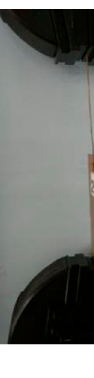
Figure 4. Thermocouple at the interface.